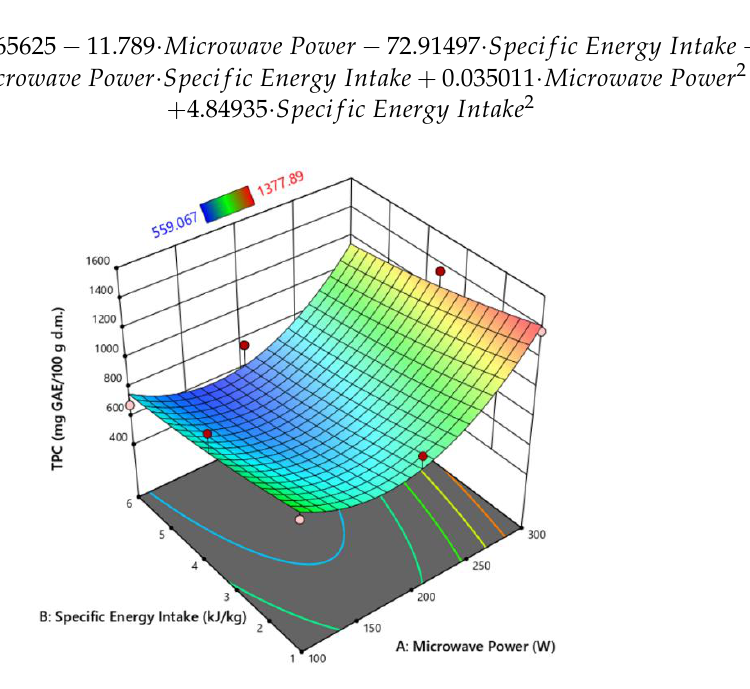
Figure 5. Response surface of total phenolic content (TPC) in apples treated with PEF prior to micro- wave-convective drying, depending on the microwave power (factor A) and specific energy intake (fac- tor B).